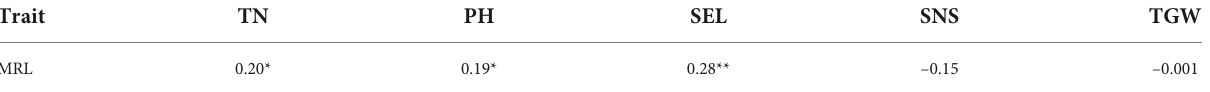
TABLE 3 Correlation coefficients between maximum root length (MRL) and yield-related traits in the 20828/SY95-71(2SY) population. Trait TN PH SEL SNS TGW MRL 0.20* 0.19*